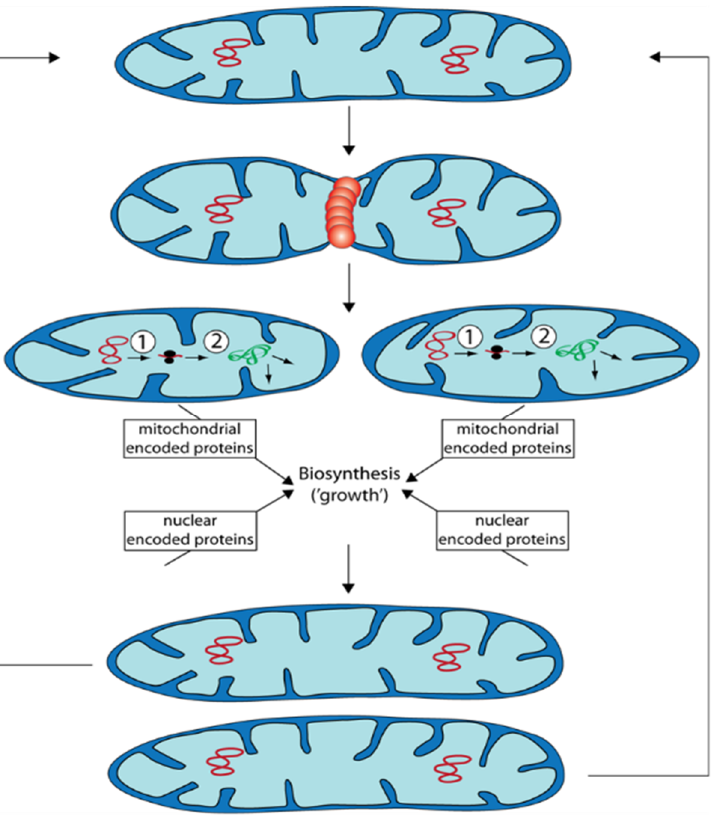
Figure 3. Propagation of mitochondria occurs via fission of prexisting organelles. After fission that is controlled by proteins (e.g., PaDNM1: orange restriction ring), the generated two mitochondria are smaller than the mitochondrion they are derived from. They “grow” depending on protein biosynthesis and on both, mtDNA (red circles) as well as nuclear DNA. Subsequently, they can divide again or they can fuse with other mitochondria. 1 (cid:13) : Transcription of mtDNA. 2 (cid:13) : Translation of RNA at mitochondrial ribosomes. Proteins (green) are subsequently sorted to the site of their function.